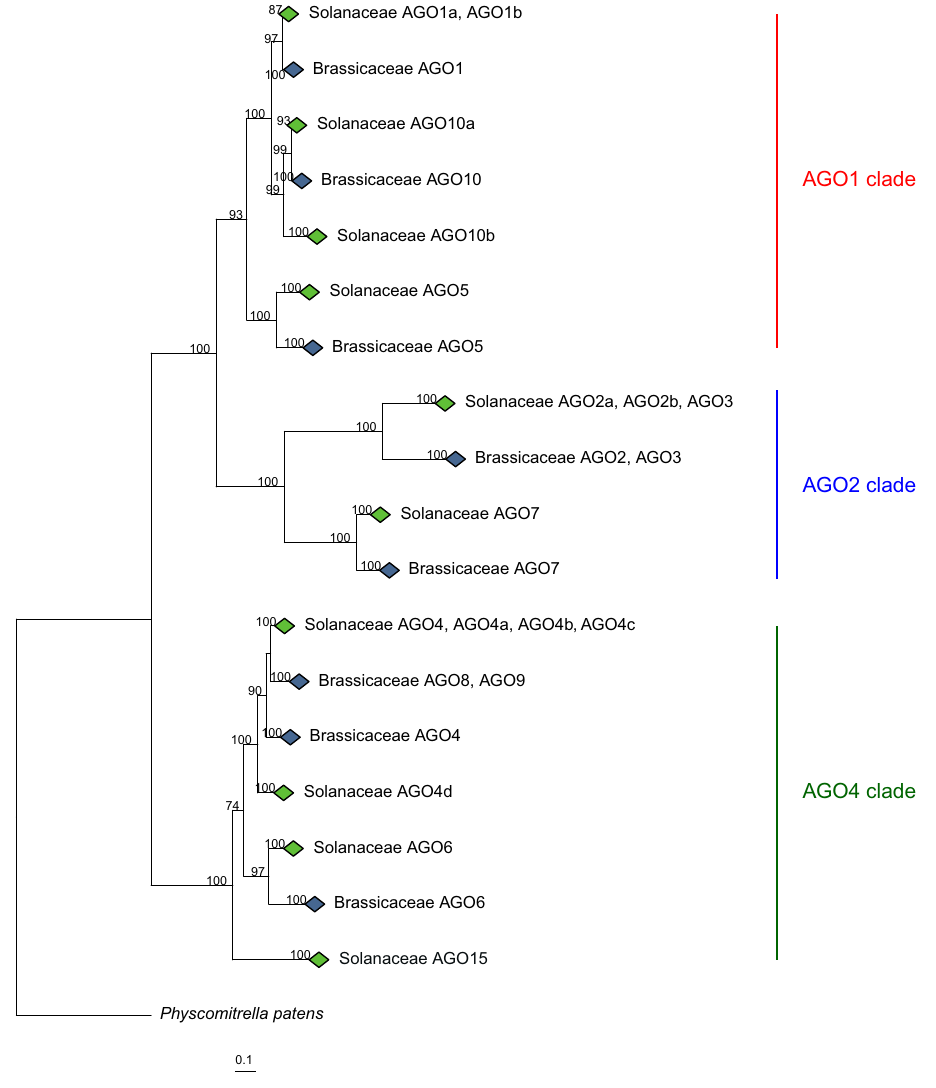
Figure 2. Maximum likelihood phylogeny (RAxML, model JTT + Γ, 100 replicates) of Argonaute (AGO) family in Solanaceae and Brassicaceae. Blue and green diamonds represent collapsed Solanaceae and Brassicaceae clades, respectively. Bootstrap values > 70% are indicated. Bar = number of substitutions per site. Outgroup = Physcomitrella patens